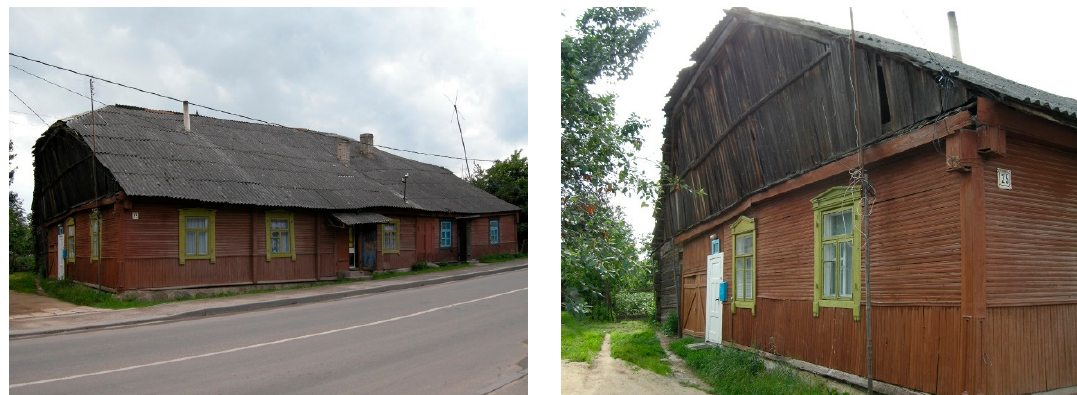
Figure 1. Jewish tavern in Oshmyany, 2009. The main dining hall and small bedrooms are in the front of the house, while the premises for the horses are located at the back of the tavern. Photo Vilma Gradinskaite.